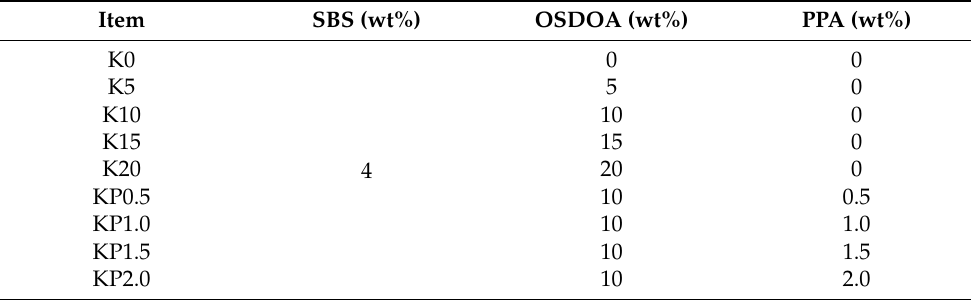
Table 5. The composition and corresponding abbreviations of all modified